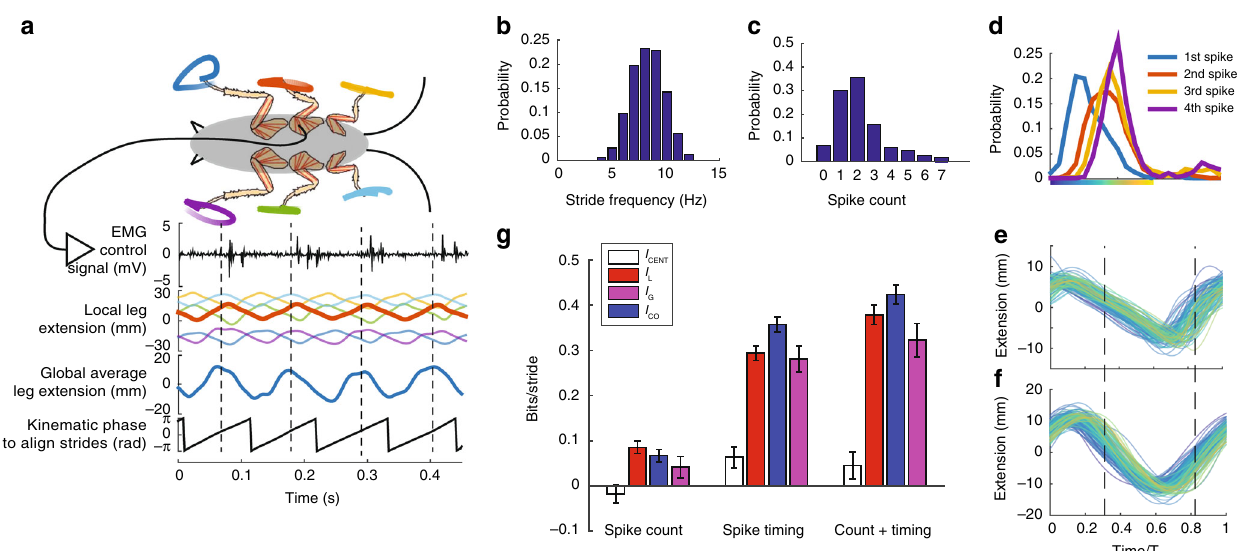
Fig. 3 Centralization of cockroach locomotion. a Control, local, and global signals recorded from the cockroach. Strides were separated according to kinematic phase calculated using the Phaser algorithm 62 . b Distribution of stride frequencies across all 2982 strides taken from 17 animals. c Distribution of the number of spikes in the femoral extensor over a stride. d Probability density functions of the timing of the fi rst four spikes if present in a stride, with time normalized by stride period T . e Local leg extension trajectories colored by the timing of the fi rst spike (colormap from d ). Correlations between the timing of the fi rst spike and the resulting local and global states evident by the fact that blue strides with an early spike are distinguished from yellow strides with a late spike. f Global leg extension trajectories colored as in e . g I CENT , I G , I L , and I CO for all